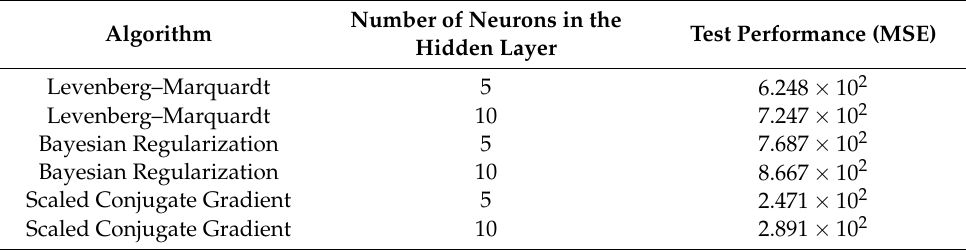
Figure 2. The NARX neural network model. Table 1. The effectiveness of the network using different learning algorithms and hidden layer neurons. Number of Neurons in the Algorithm Hidden